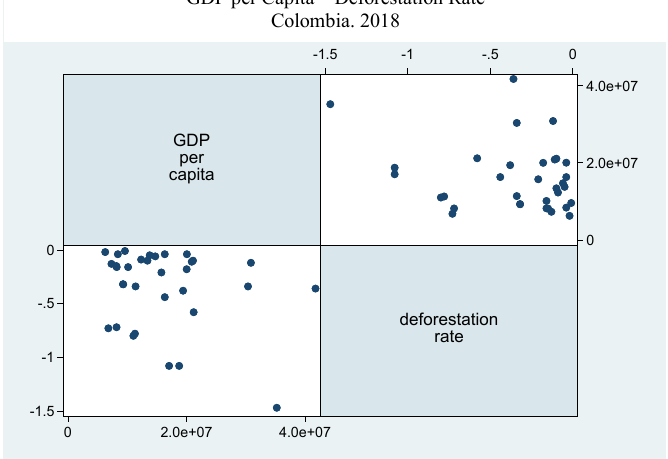
Fig. 1. Relationship between GDP per capita and deforestation rate for Colombia